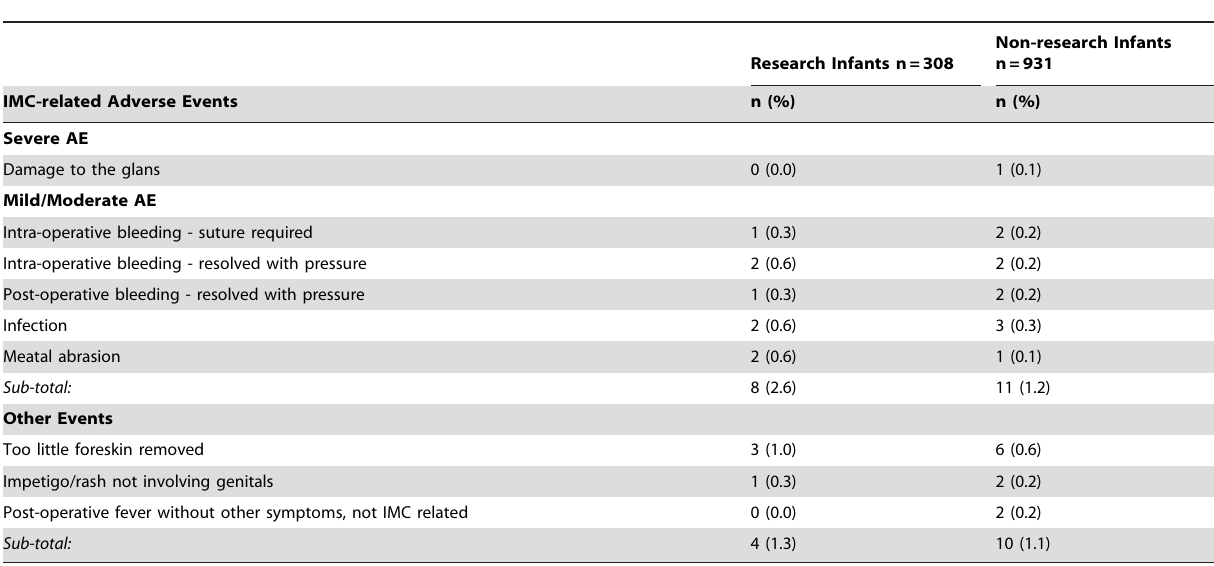
Table 2. Type and frequency of adverse events and other